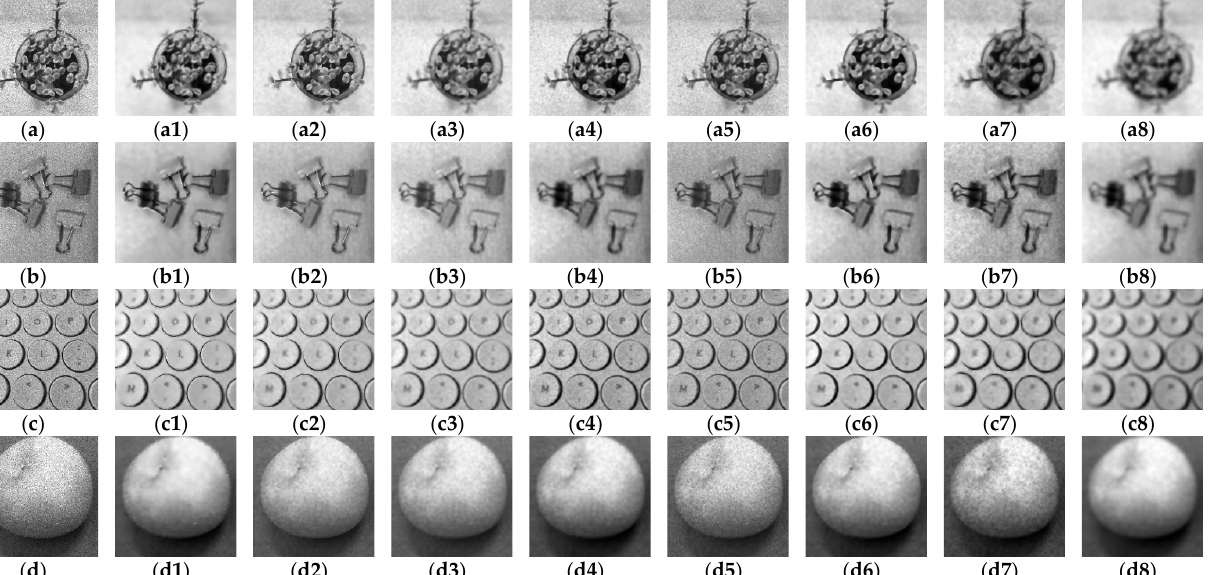
Figure 14. SSIM results for the speckle suppression on synthetic image.